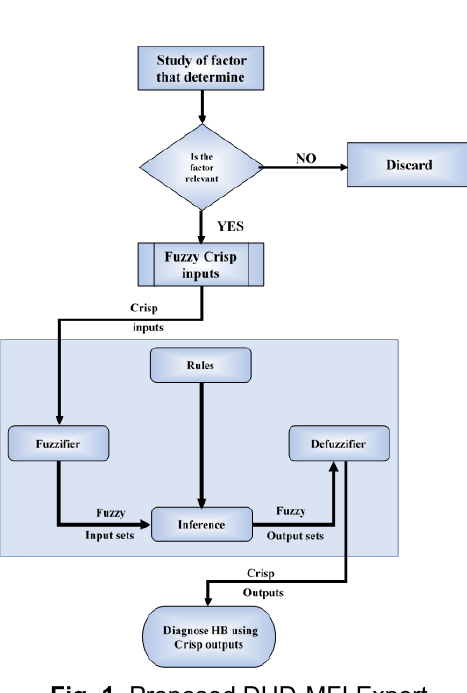
Fig. 2. Proposed DHD-MFI Expert System